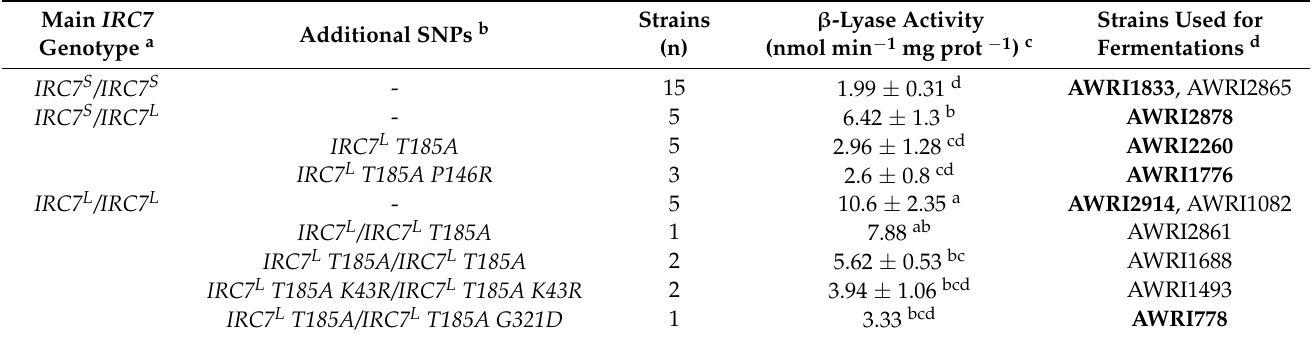
Table 1. Summary of β -lyase activity towards S -(2-Thiazolyl)-L-cysteine (STC) in cell-free protein extracts from 39 wine strains with different IRC7